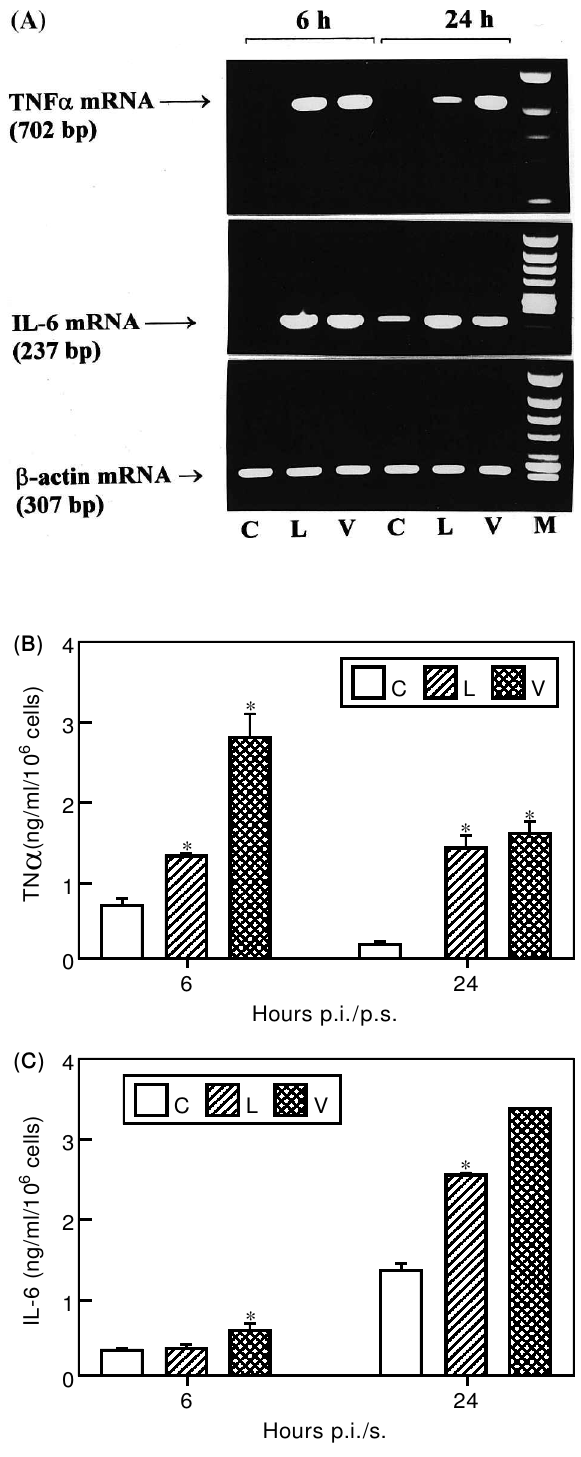
FIG. 3. Changes in TNF a and IL-6 gene expression in vaccinia virus infected U937 cells. TNF a , IL-6 and b -actin mRNAs were measured by RT-PCR (A) and the cytokines secretion deter- mined by ELISA (TNF a –B; IL-6–C). RT-PCR data come from a single representative experiment, whereas cytokine proteins were analysed in culture media from three experiments and standard deviation shown where it was possible. Vaccinia virus infection was at MOI 1:1. C–control cultures, V–vaccinia virus infected cultures, L–LPS-treated cultures (performed as a positive control). Results are expressed as the mean ± standard deviation. Statistically significant results and P values < 0.01 are marked